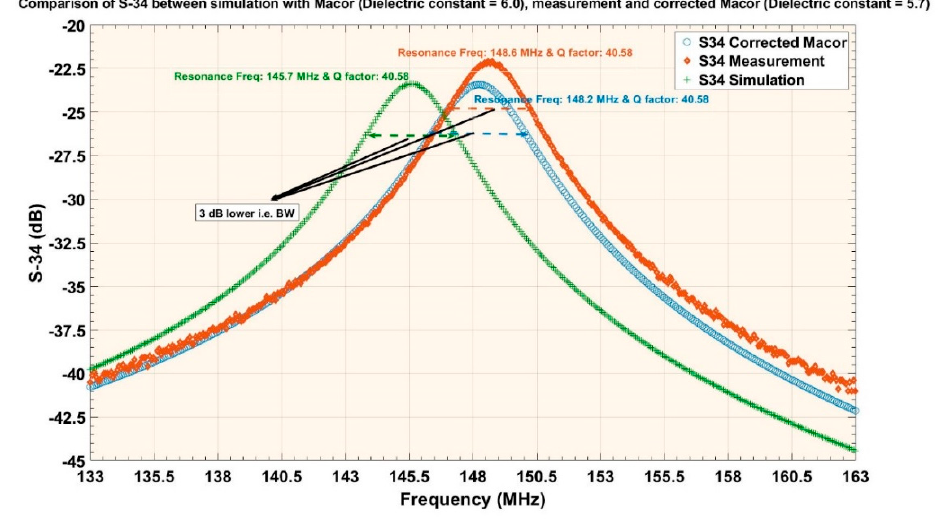
Figure 13. Comparison between first simulation ( ε r = 6.0), measurement and simulation with corrected Macor ( ε r = 5.7) of the resonator. The Q factors and the resonance frequency are also mentioned.